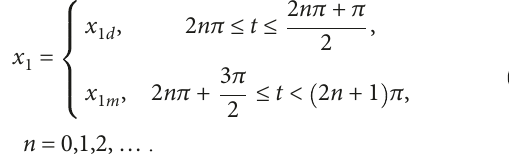
Figure 16: The state trajectories of the error system. (a) State trajectories of e trajectories of e 4